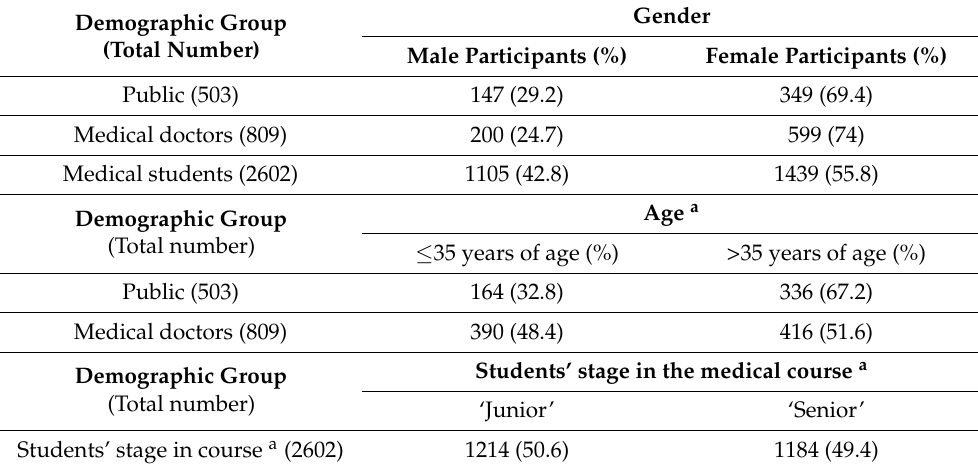
Table 2. Demographic Details of PoMS Survey Participants: Gender/Age/Medical Students’ Seniority a